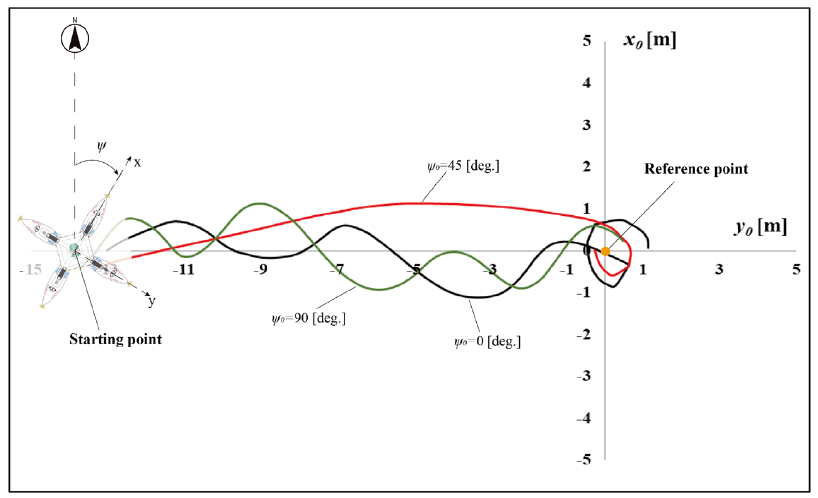
Figure 16. The trajectory of the running tests in calm water .